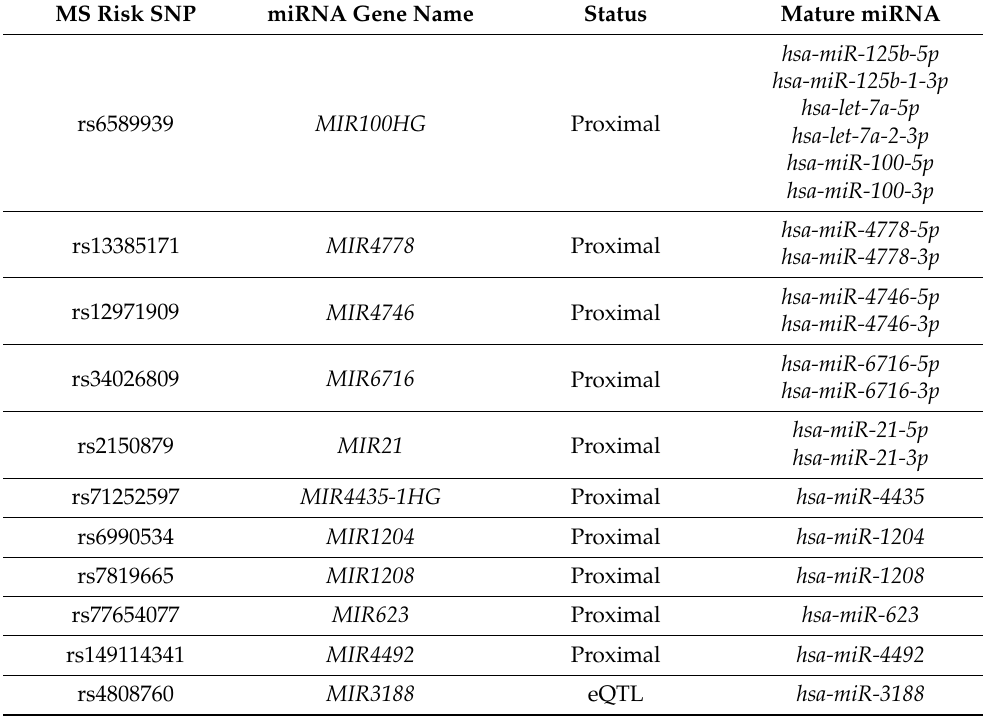
Table 1. MS risk miRNAs.